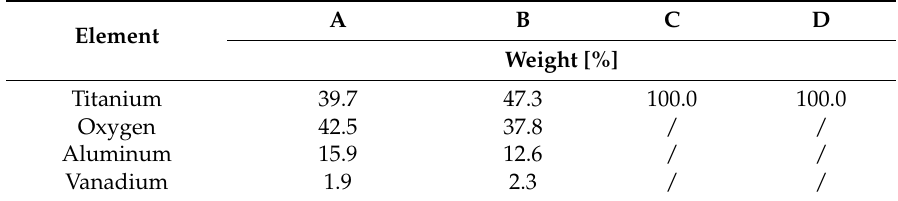
Table 7. Chemical compositions of the dental implants.